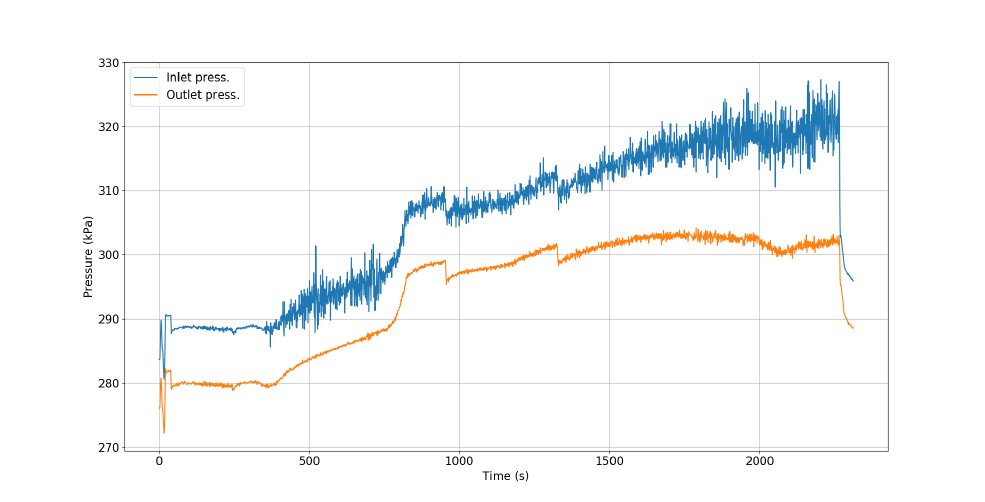
Figure 18. Pressures during 300 kPa and 600 kg/(m 2 . s)